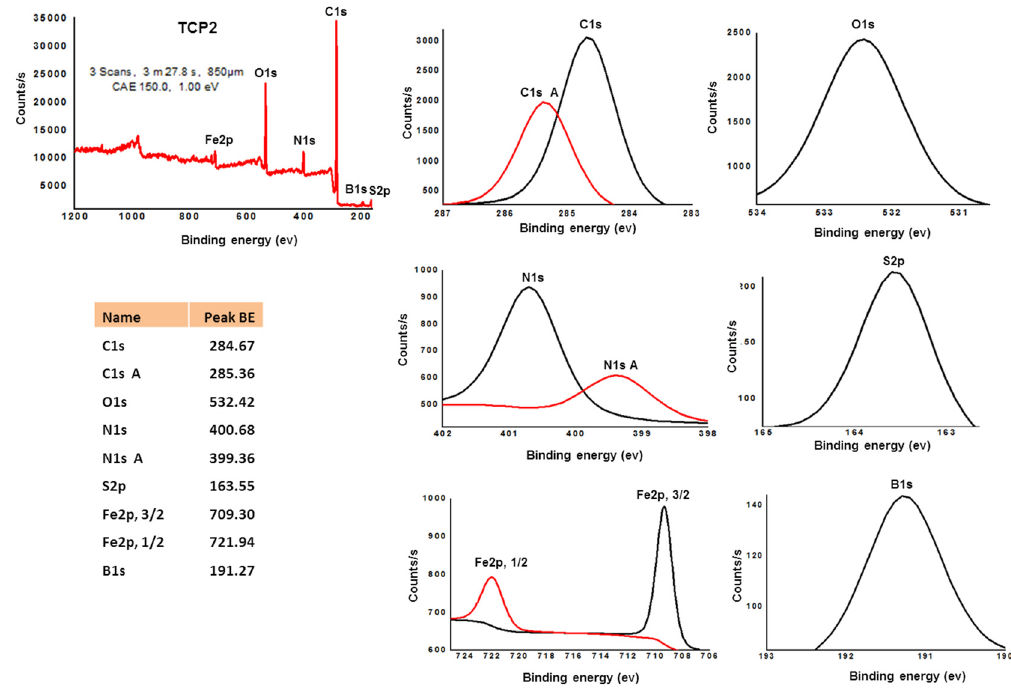
Figure 4. High-resolution survey scan XPS spectra of C1s, O1s, N1s, S2p, Fe2p, and B1s of TCP2.